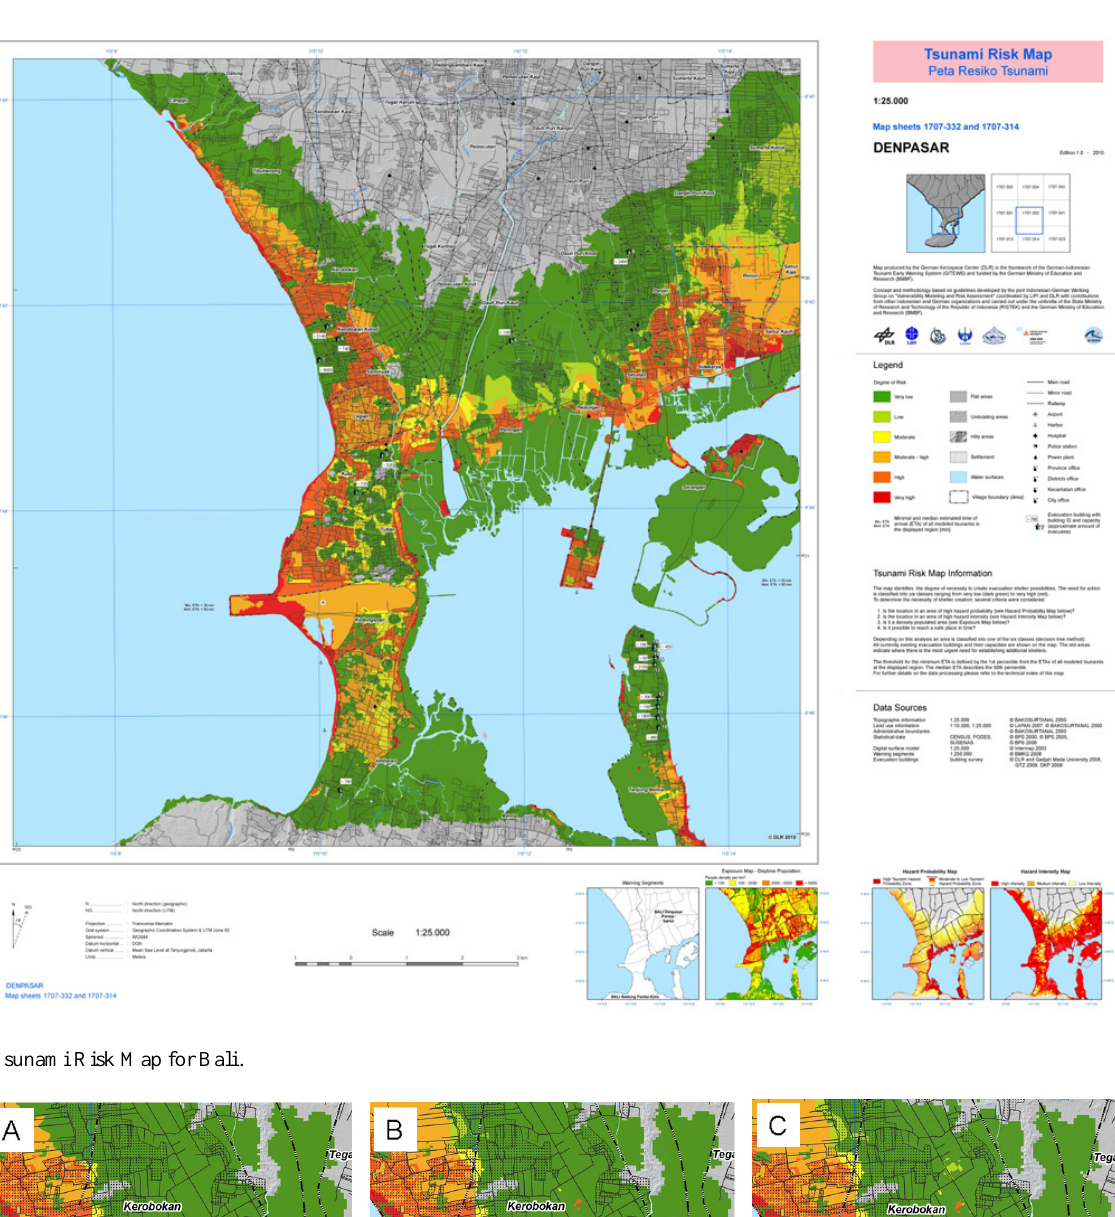
Fig. 5. Tsunami Risk Map for Bali.